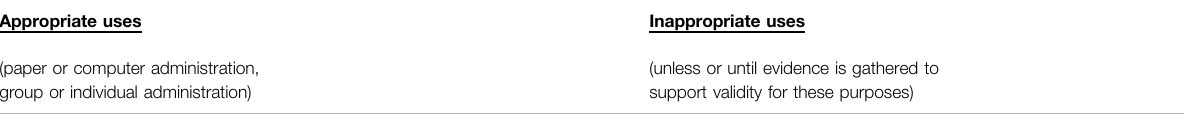
TABLE 1 | IMRB: Summary of appropriate and inappropriate uses. Appropriate uses (paper or computer administration, group or individual administration)